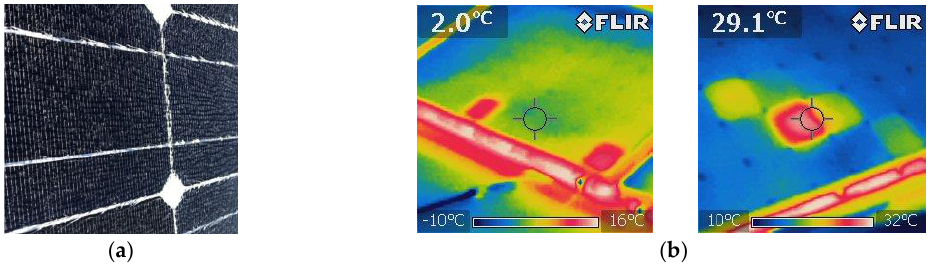
Figure 3. Cumulative degradation rates for PV systems D and E in 2008, 2013, and 2017: ( a ) PV site D—Glasgow; ( b ) PV site E—Aberdeen.